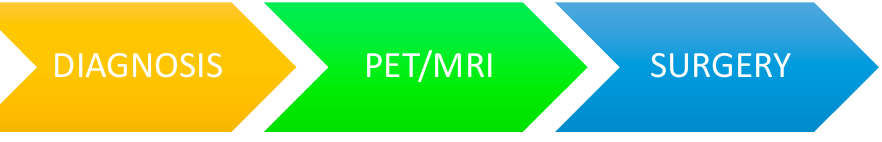
Figure 1. SNB vs. PET/MRI 1 flow-chart. (PST=Primary Sistemic Therapy).